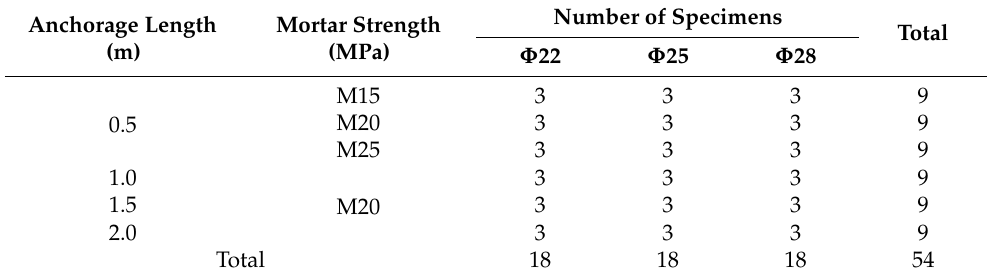
Table 1. GFRP pull-out test conditions.